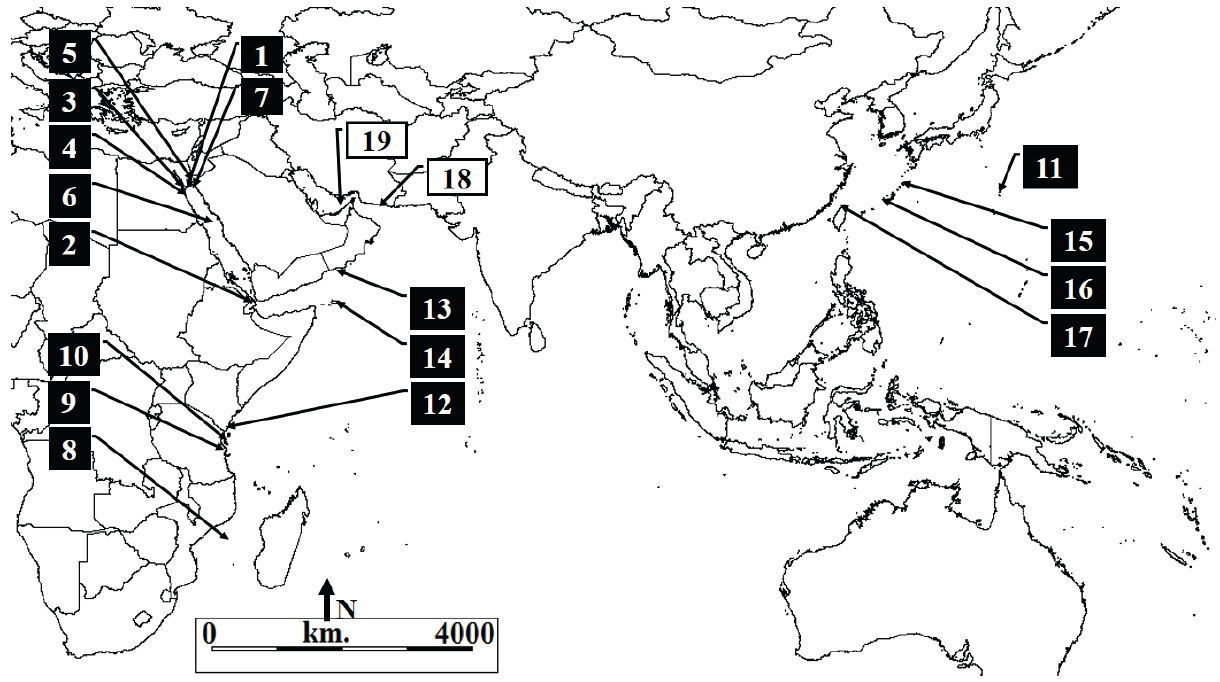
Figure 2. The World distribution and new records of the Petrolisthes virgatus (Paul’son, 1875): (1) Goal or Ras Muhammad, Sinai Peninsula, Red Sea (type locality) (Paul’son, 1875); (2) Obock, Djibouti, Gulf of Aden (Nobili, 1906); (3) Shadwan Island in the mouth of the Gulf of Suez, Egypt, Red Sea (Balss, 1915); (4) Ghardaqa, Egypt, Red Sea (Ramadan, 1936); (5) Elath, Gulf of Aqaba, Red Sea (Lewinsohn, 1979); (6) unknown exact locality, Red Sea (E. Rüppell collector, 1826: deposited in Senckenberg Museum at Frankfurt, accessible via http://sesam.senckenberg.de/page/index.htm); (7) Tabuk, Saudi Arabia, Red Sea (B. Werding collector, 2013: deposited in Senckenberg Museum at Frankfurt, accessible via http://sesam.senckenberg.de/page/index.htm); (8) Mozambique (Barnard, 1955; Kalk, 1958; Macnae and Kalk, 1958; Kensley, 1970); (9) Dar es Salaam, Tanzania (Ortmann, 1894) as P. trivirgatus Ortmann, 1894; (10) Zanzibar, Tanzania (Lenz, 1905) as P. trivirgatus (see Taramelli, 1955); (11) Hirashima, Ogasawara Island, Japan (Ooishi, 1970); (12) Sar Uanle, south of Chisimaio, Somalia (Lewinsohn, 1969); (13) Mughsayl and Mirbat, southern Oman (Hogarth, 1988); (14) Socotra Island, Indian Ocean (Simões et al ., 2001); (15) Amami Group Island, Japan (Nakasone and Miyake, 1972); (16) Yakabi-Jima Island, Ryukyu Archipelago, Japan (Nomura et al ., 1996); (17) Fan-Zai-Aou Bay, southern East China Sea, off the coast of Keelung City in northern Taiwan (Limviriyakul et al ., 2016); with new records of this species from (18) the Djod Village, Sistan and Balouchestan Province, Gulf of Oman, Iran (present study) and (19) the Abu-Musa Island, Persian Gulf, Iran (present